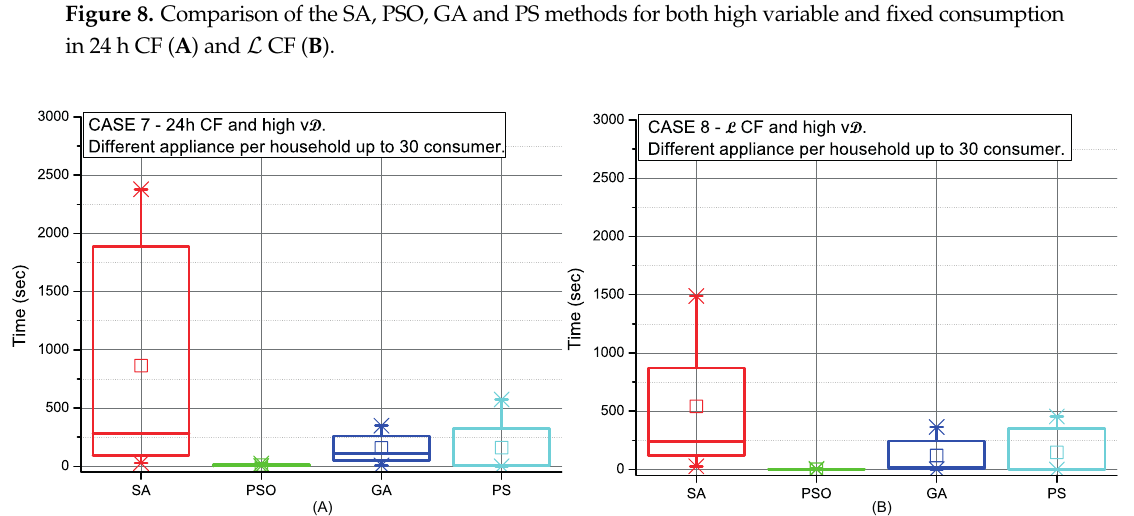
Figure 9. Comparison of the SA, PSO, GA and PS methods for both high variable and fixed consumption in 24 h CF ( A ) and L CF ( B